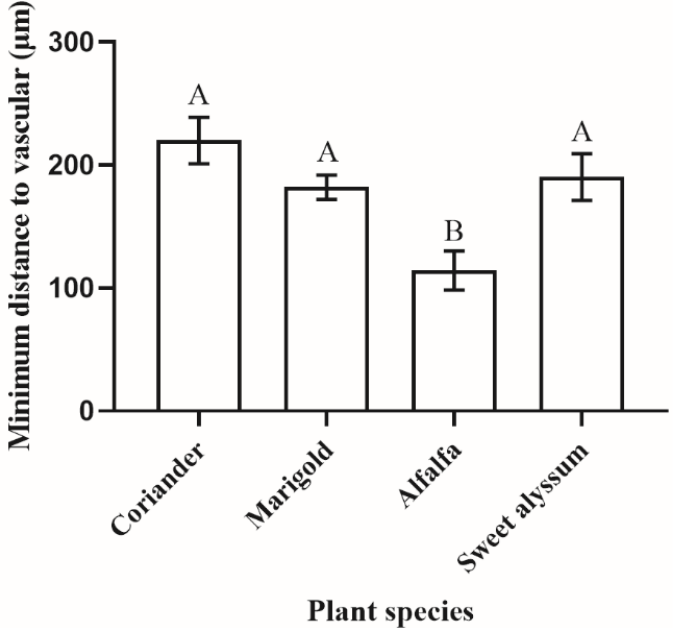
Figure 10. Minimum distance from the epidermis to vascular tissue of stems in different plant species near oviposition sites of Orius sauteri ( n = 3 for alfalfa, n = 6 for other plant species) ( α = 0.05; ANOVA). Values are mean ± SE. Means indicated by the same letter are not significantly different according to LSD test.